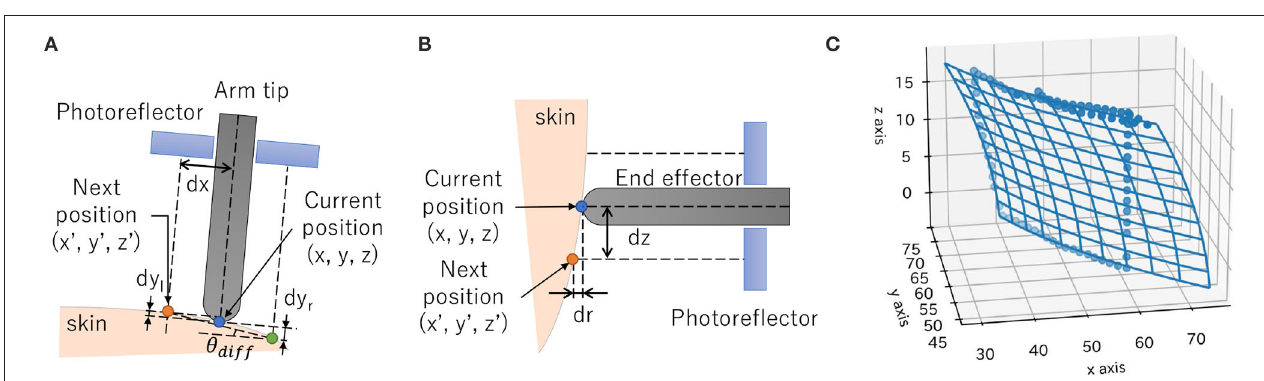
FIGURE 3 | Cheek surface calibration. (A) Cheek surface tracking in a horizontal direction. (B) Cheek surface tracking in a vertical direction. (C) Fitted quadratic surface to points on the cheek surface. Blue markers were the actual points on the cheek surface. The wireframe was an estimated surface.